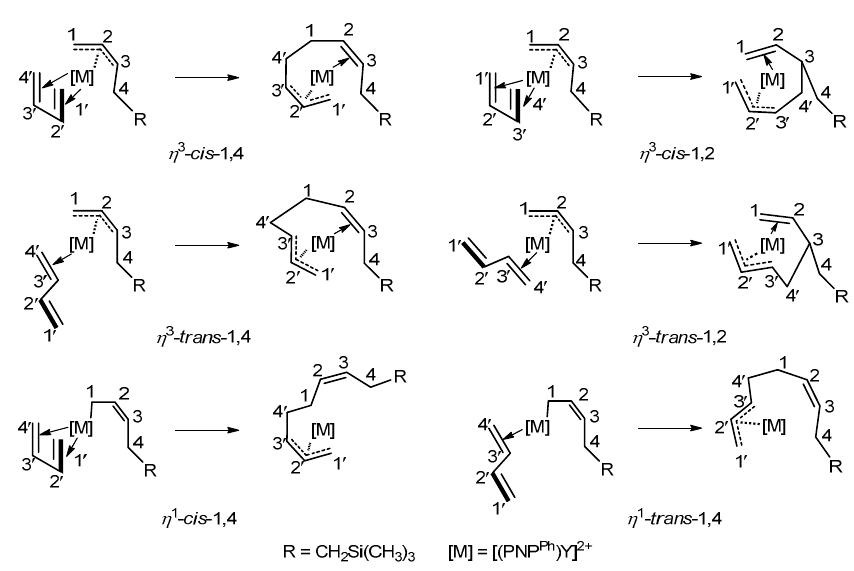
Table 1. Energy profiles a for insertion of the second butadiene into the metal–butenyl bond of thf P1 cis . Mechanism Insertion fashions thf C2 thf TS2 thf P2